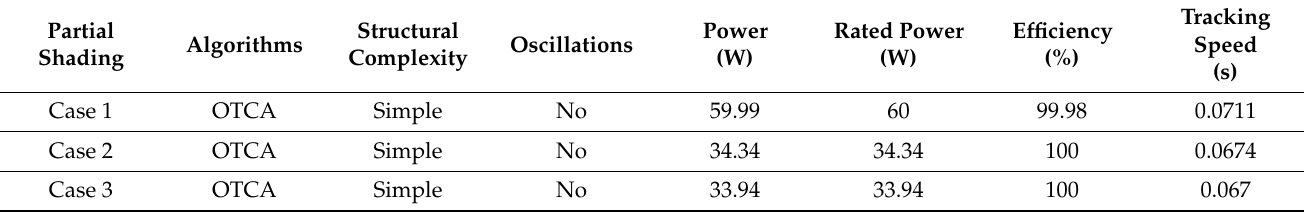
Figure 34. Simulation results for 2S PV system: ( a ) ten check algorithm for test case 1; ( b ) ten check algorithm for test case 2; ( c ) ten check algorithm for test case 3. Table 10. Performance comparison of OTCA for 2S PV system for all test cases.